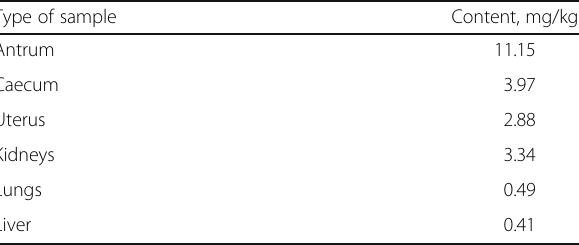
Table 1 The concentration of Ti in the investigated